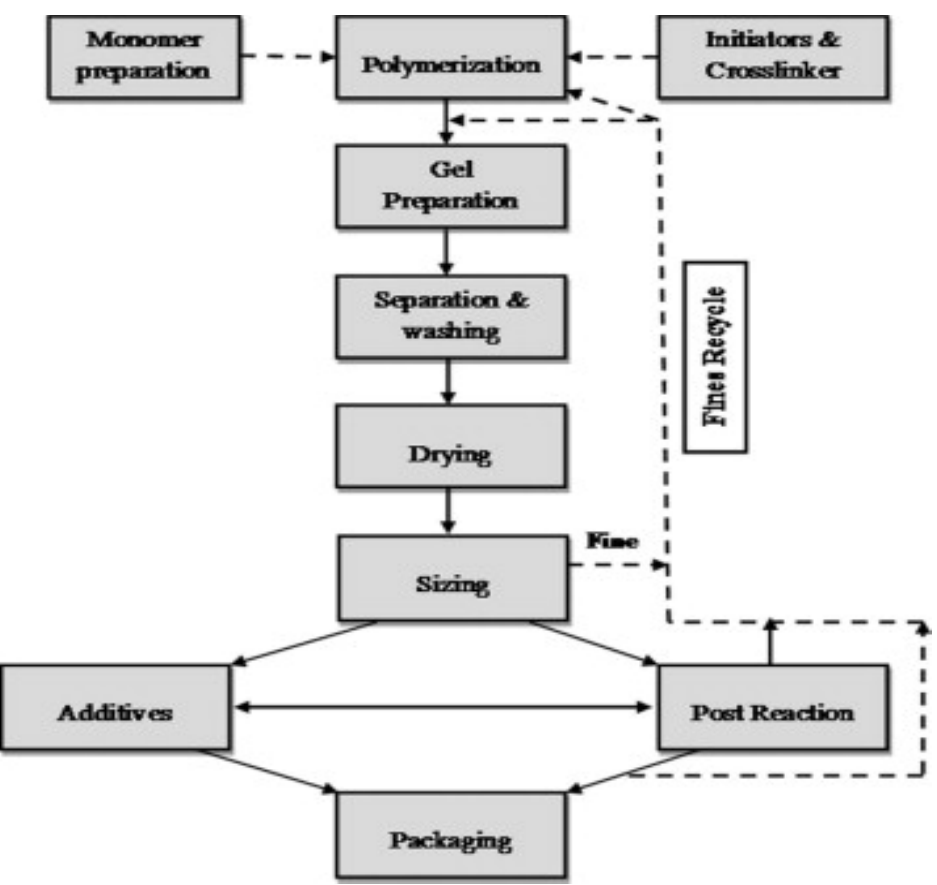
Figure 6. The primary steps for making hydrogels on a semi-pilot and industrial scale. Adapted from Ahmed et al. [76].